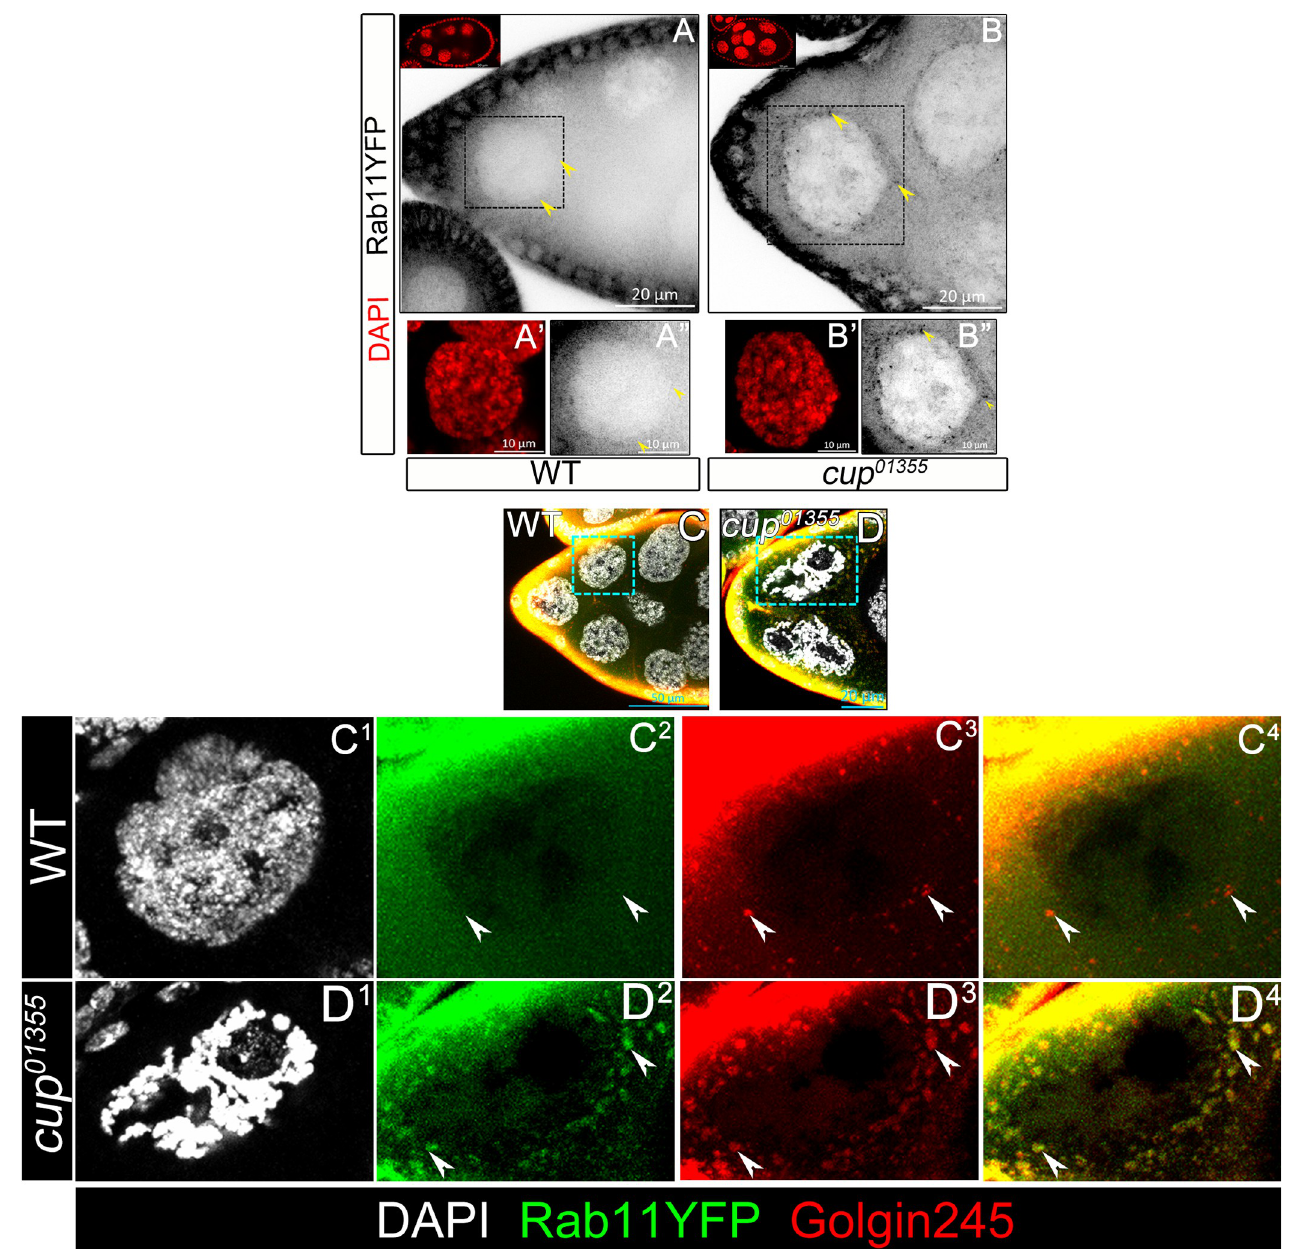
Fig 7. Cup mutants exhibit Rab11 enrichment in the trans-Golgi network. (A-B”) Rab11-YFP puncta is enriched in the nurse cell peri-nuclear zone of cup 01355 egg chambers. A’,A” and B’, B” are the magnified square region outlined in A and B respectively. Rab11-YFP (black) indicated by yellow arrowhead, DAPI (red). (C-D, C 1 -D 4 ) Rab11-YFP colocalizes with trans-Golgi network marker Golgin-245 at periphery of nurse cell nucleus in the cup 01355 egg chambers. Rab11-YFP (green) indicated by white arrow heads, Golgin-245 (red) and DAPI (white).